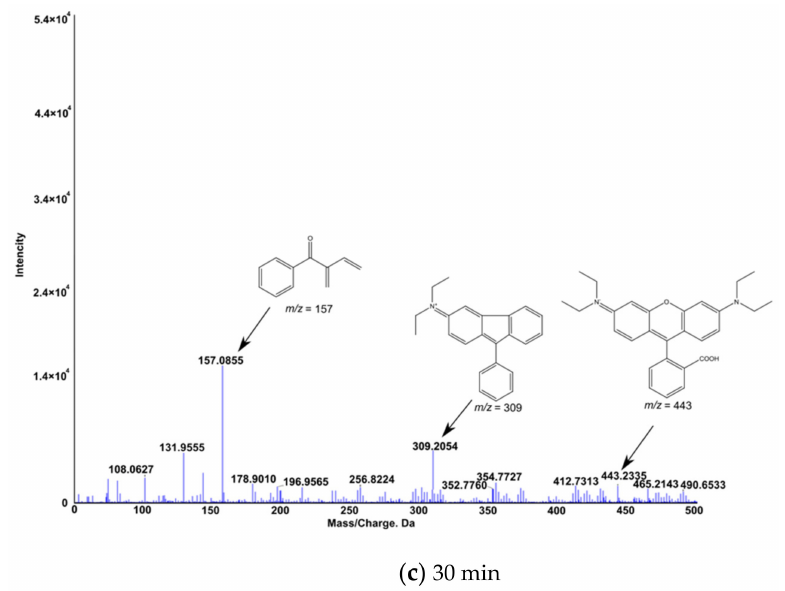
Figure A1. Mass spectra of the treated solutions at different treatment times: ( a ) initial, ( b ) 15 min, and ( c ) 30